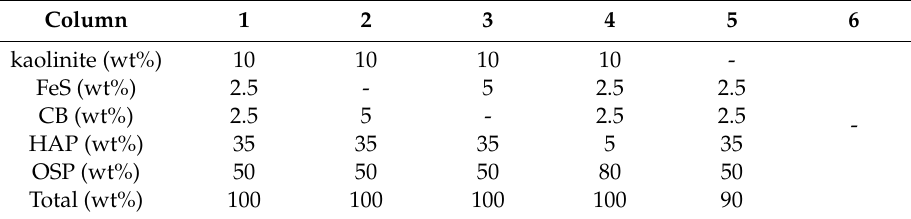
Table 4. Six columns covered by di ff erent mixed